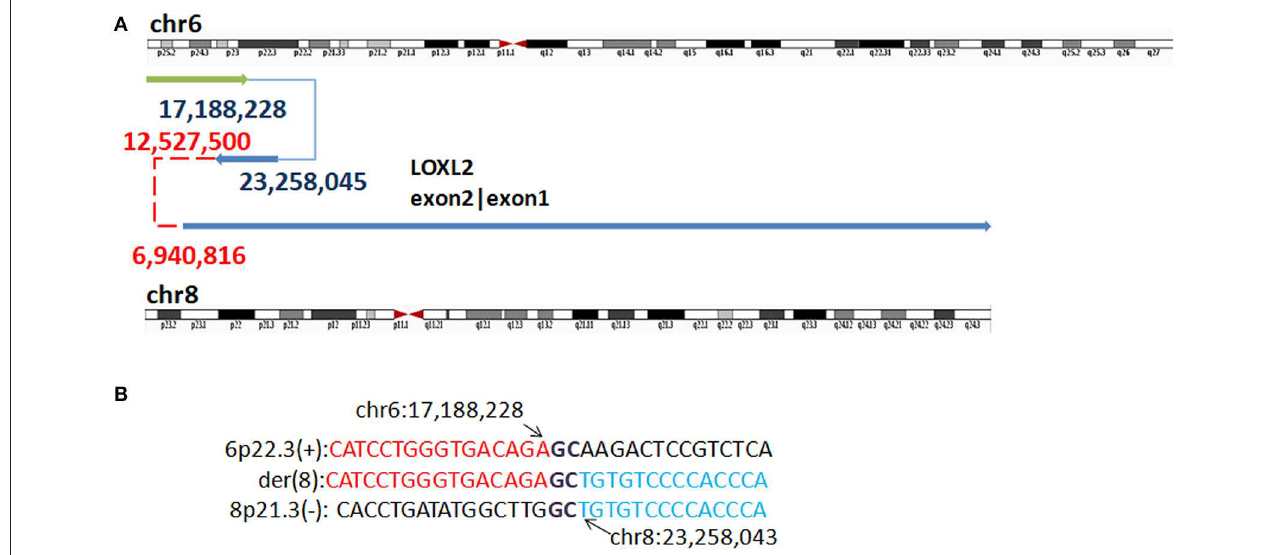
FIGURE 5 | Breakpoints in P3. (A) Breakpoints analysis found four fusion breakpoints: 17,188,228 (6p25.3), 23,258,045 (8p21.3), 12,527,500 (8p23.1), and 6,940,816(8p23.1), and in which chr8: 12,527,500 and 6,940,816 were not validated by Sanger sequencing (marked as red). (B) The breakpoints mapped at the base-pair level by Sanger sequencing. Rearrangement junction sequences (middle line) and matching reference sequences (top and bottom lines) are shown with different colors depending on the involved chromosome region. Sequences in bold purple represent